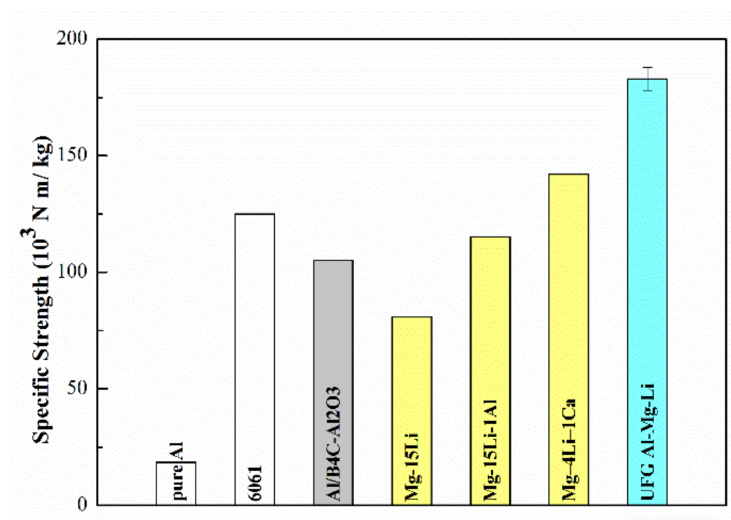
Figure 9. Specific fracture strength of ECAPed Al-5.5Mg-xLi-0.1Zr alloy and other types of